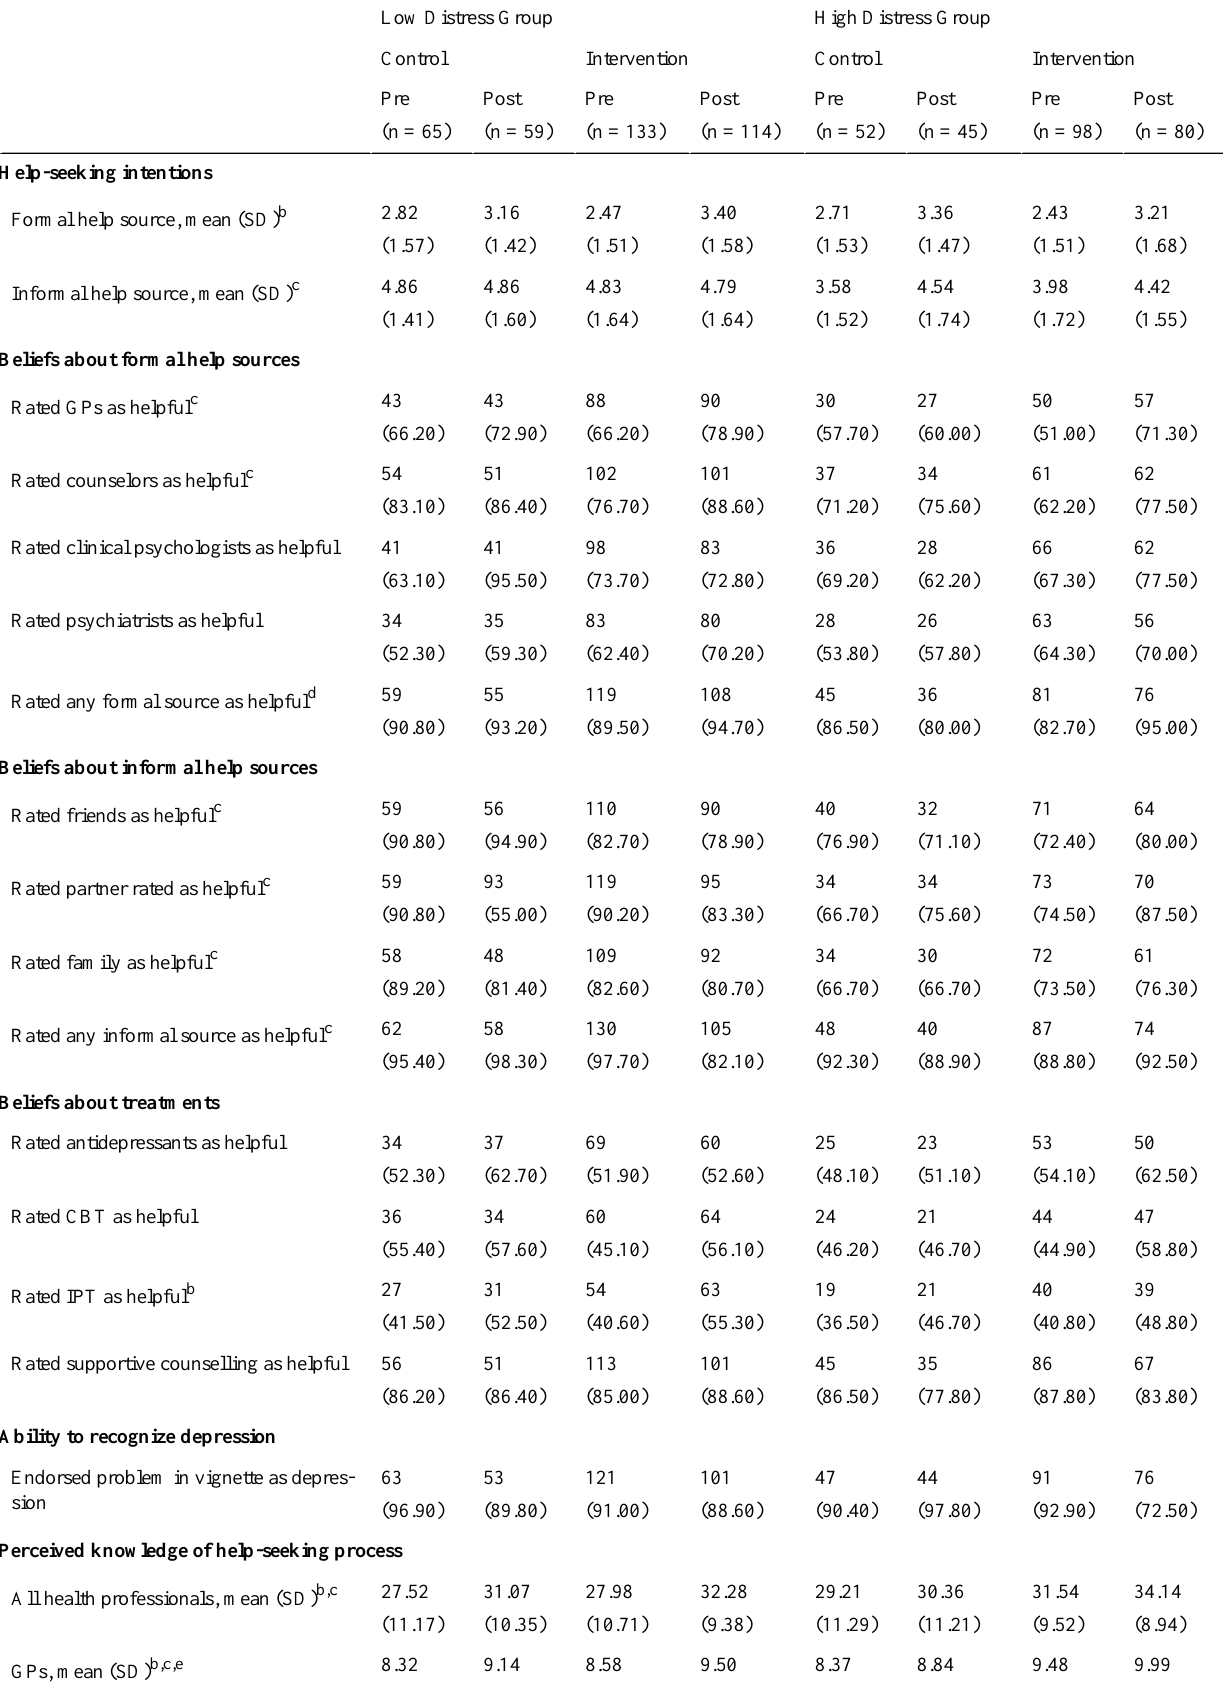
Table 3. Secondary outcomes a